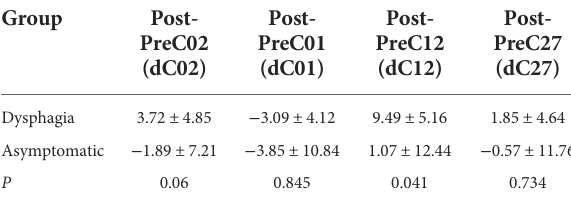
TABLE 1 Comparison of general information in dysphagia and asymptomatic groups.